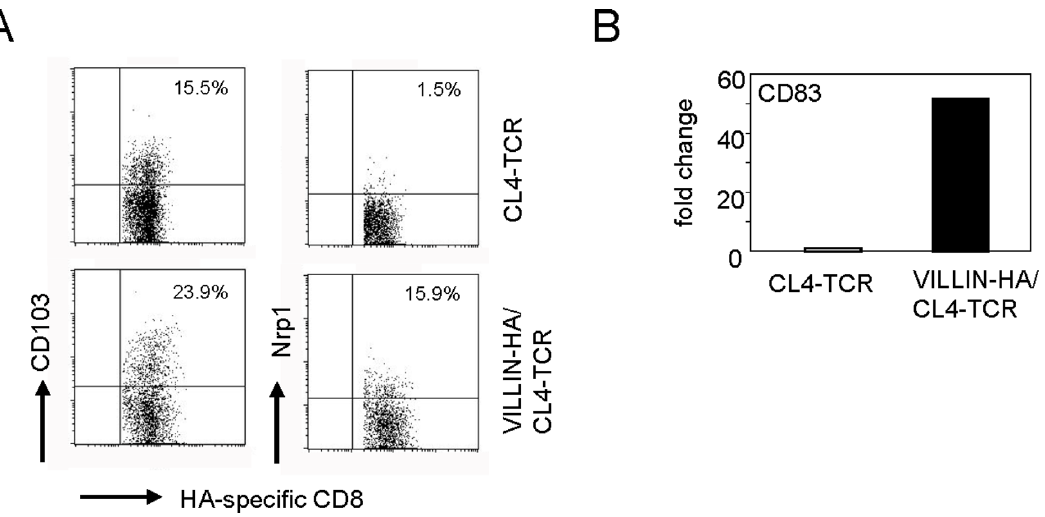
Figure 3. Phenotype of HA-specific CD8 + T cells from VILLIN-HA/CL4-TCR transgenic mice. (A) Cells isolated from the MLN of CL4-TCR and VILLIN-HA/CL4-TCR transgenic mice were stained for the expression of CD8, H-2K d IYSTVASSL, CD103 and Nrp1. Dot plots represent the percentage of HA-specific CD8 + T cells expressing the indicated molecules. (B) HA-specific CD8 + T cells were isolated from the MLN of CL4-TCR and VILLIN-HA/CL4- TCR transgenic mice by cell sorting. CD83 expression was assayed by quantitative RT-PCR and normalized relative to expression of RPS9. Data shown are representative of three independent experiments.